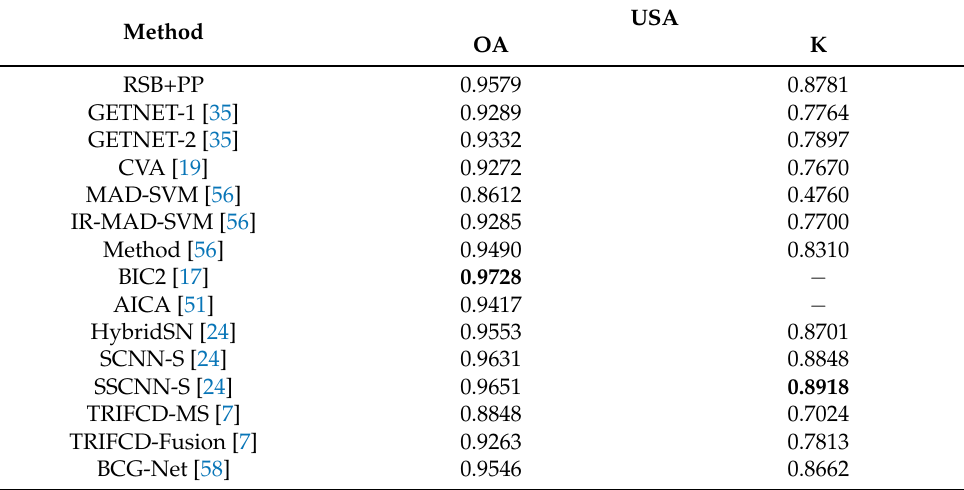
Table 4. The proposed approach, RSB, with post-processing, and other competitors on the USA dataset. The best results are displayed in